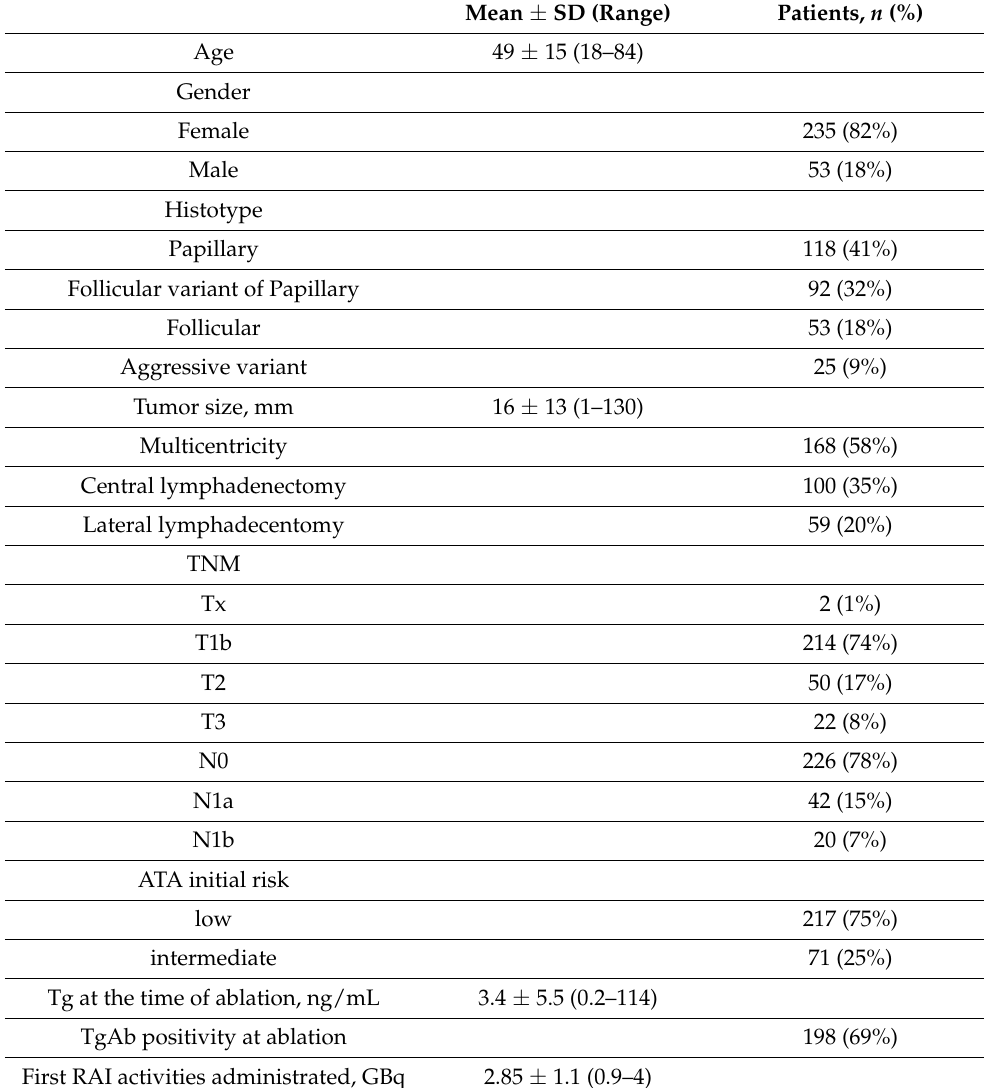
Table 1. Baseline features of patients with indeterminate responses after initial therapy ( n =